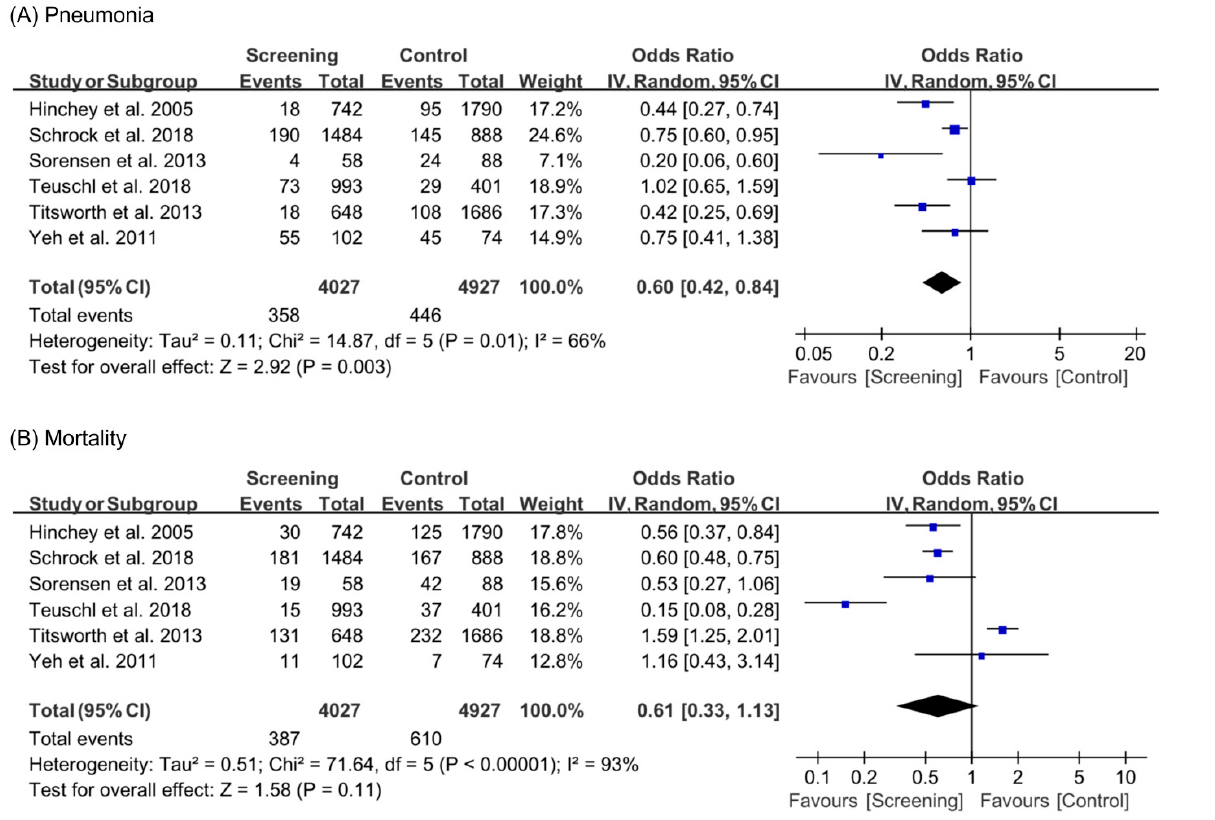
Figure 3. Forest plot showing the results of ( A ) pneumonia and ( B ) mortality after dysphagia screening in acute stroke patients.